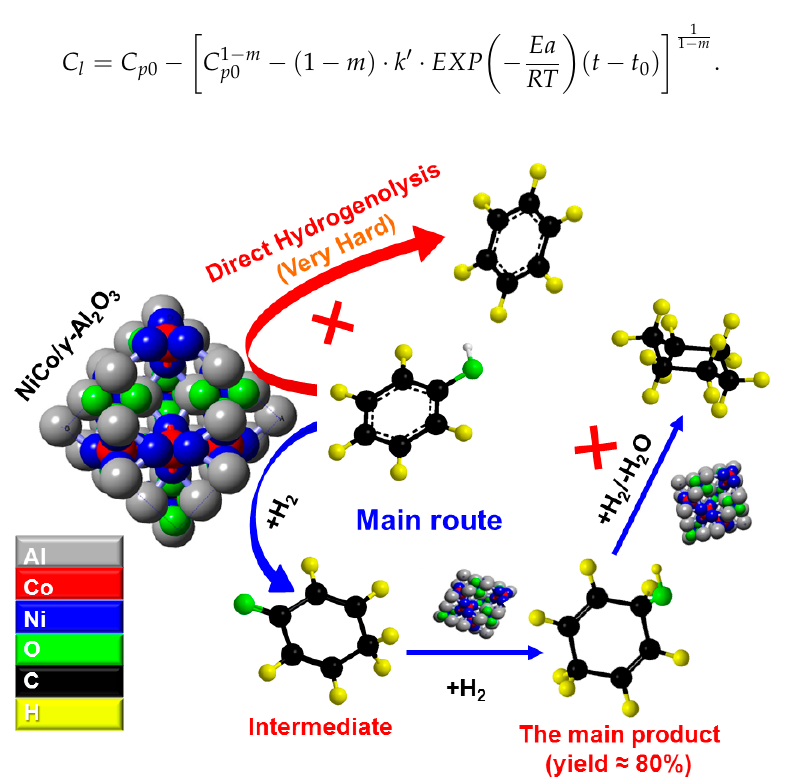
Figure 7. The possible reaction paths of phenol during subcritical hydrothermal conversion.